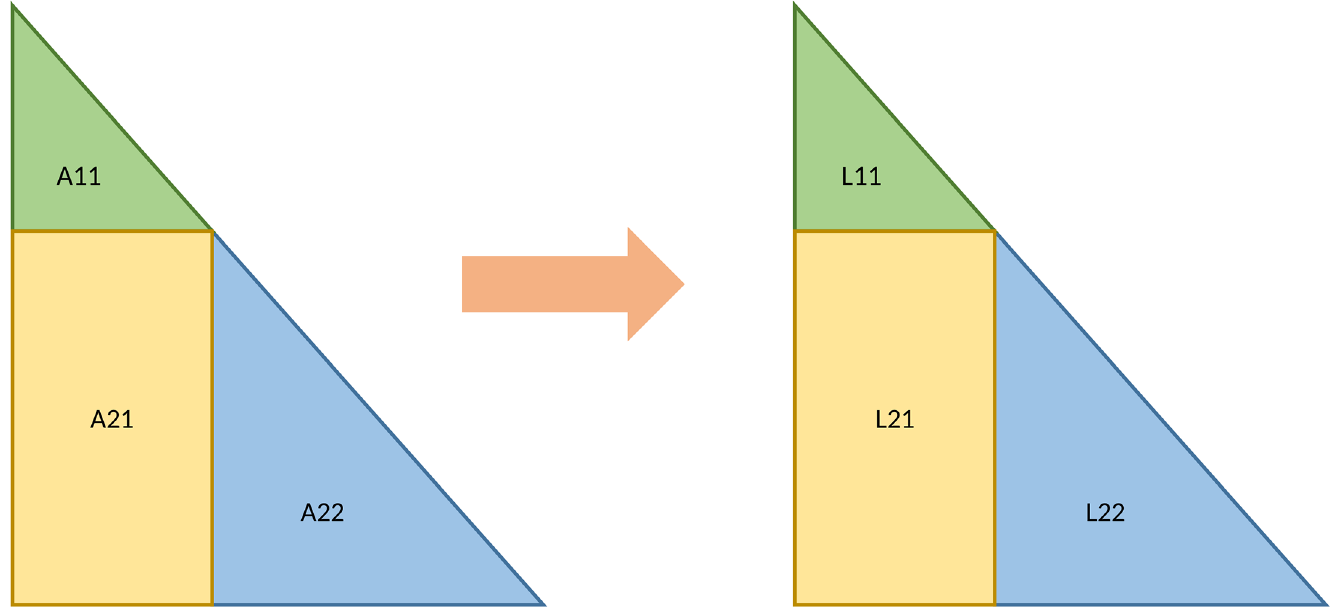
Fig 1. A step of the blocked Cholesky decomposition.